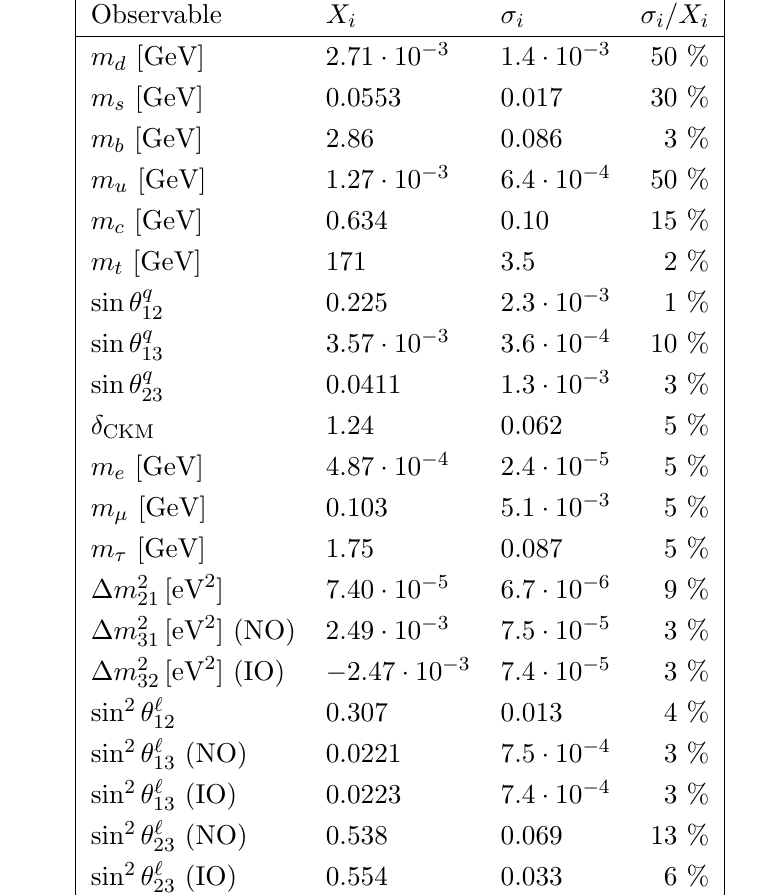
Table 2 . Mean values of the 18 observables and corresponding errors at the electroweak scale M Z . The label NO (IO) denotes the parameter values of normal (inverted) neutrino mass ordering. Mean values of the quark and charged-lepton masses are based on updated calculations of refs. [39, 40] and mean values of the quark mixing parameters are computed from values given in ref. [28]. The neutrino mass-squared di(cid:11)erences and the leptonic mixing angles are taken from refs. [41, 42].